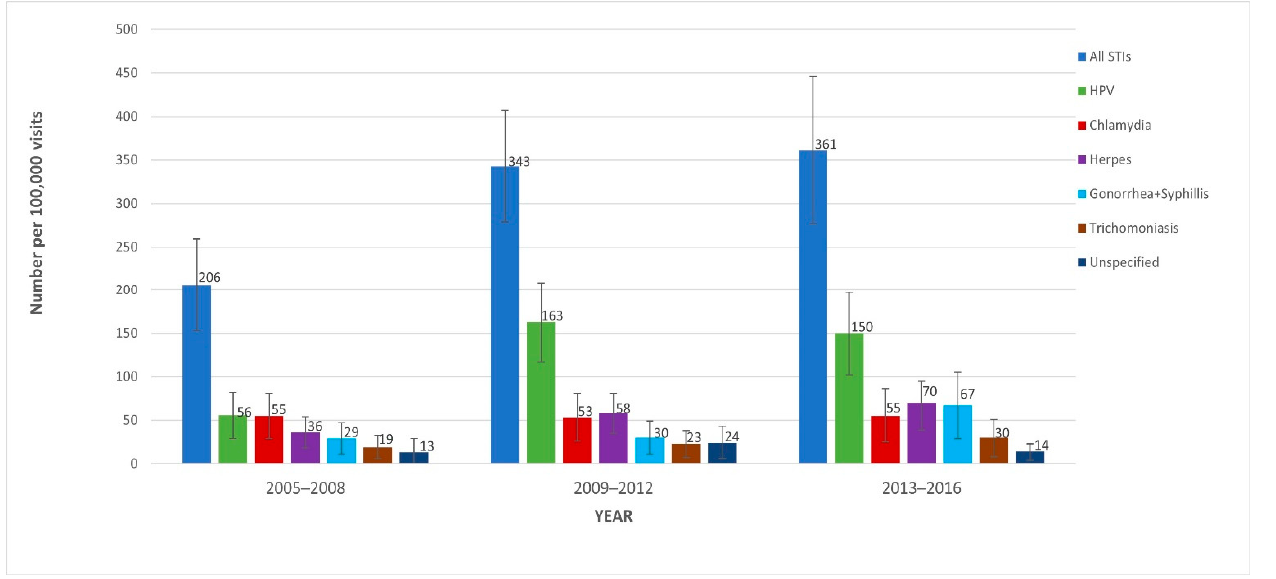
Figure 1. Prevalence of sexually transmitted infection (STI) diagnoses in ambulatory care settings from 2005–2008 to 2013–2016 using data from the National Ambulatory Medical Care Survey (NAMCS). All STIs: chancroid, chlamydia, granuloma inguinale, gonorrhea, herpes, HPV, syphilis, trichomoniasis, unspecified STI, and Reiter’s disease; HPV: human papillomavirus. Note: logistic regression was used to compare the three time periods for all STIs ( p = 0.003).